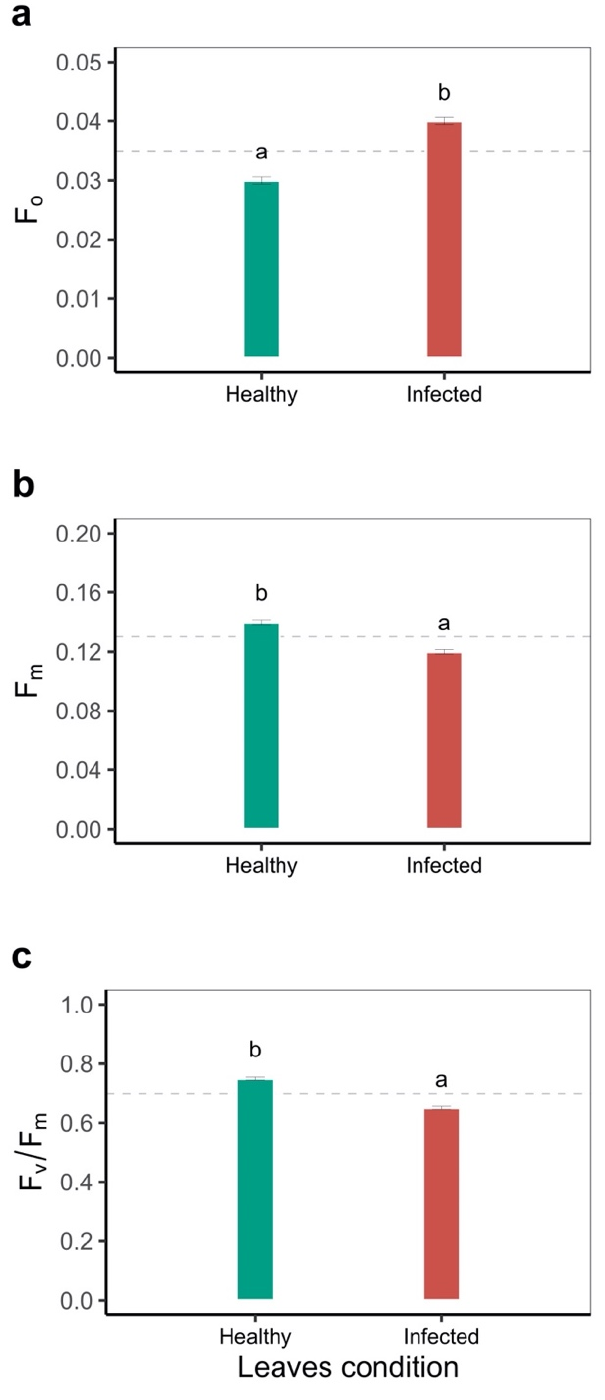
Figure 1. Photochemical status of fully oxidized and reduced photochemistry II (PSII) of different bean genotypes with susceptibility to disease stress. ( a ) Initial fluorescence (F 0 ); ( b ) maximal fluorescence (F m ); ( c ) the maximum quantum yield of the PSII photochemistry F v /F m . The dashed black line corresponds to the mean of each variable. a, b: Letters for the bars for each leaf condition indicate statistically significant differences based on the LSD means test ( p < 0.05). Results include the mean ± SE (n = 2832 leaves).